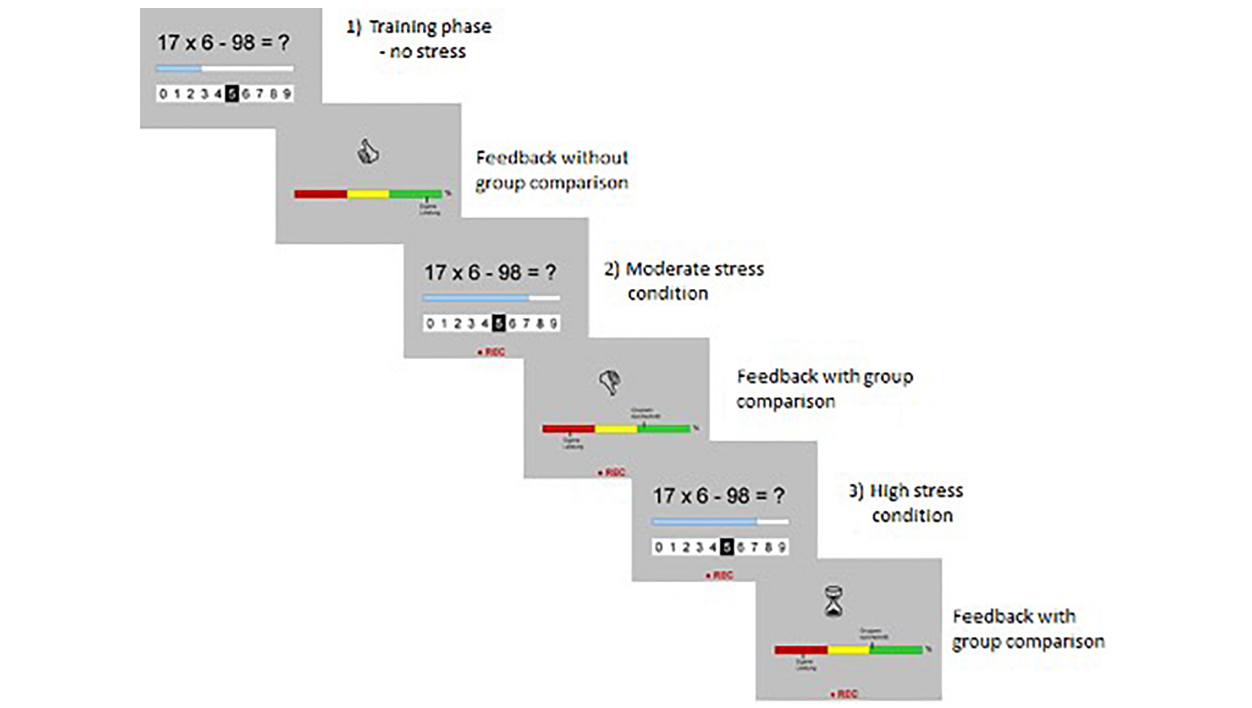
FIGURE 1 | Process of the modified Montréal Stress Imaging Task (MIST) (Zschucke et al., 2015).